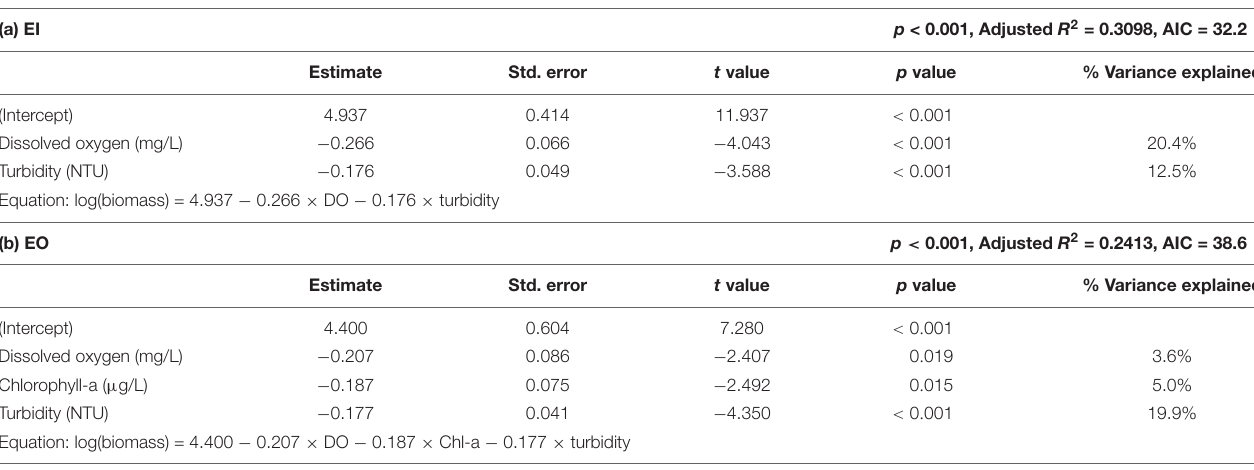
FIGURE 3 | Mean levels (+SEM) of turbidity (A) , dissolved oxygen [(DO; (B) ], pH (C) , and chlorophyll-a [Chl a; (D) ] obtained from the Environmental Protection Department of Hong Kong for water samples that were collected in inner Tolo Channel (EI) and outer Tolo (EO) during January 2004 to December 2004 (2004; before the trawl ban), June 2013 to May 2014 (2013–2014; after the trawl ban), and June 2015 to May 2016 (2015–2016; after the trawl ban). In each panel and site, bars with different letters are significantly different ( p < 0.05), whereas n.s. denotes no significant difference between the mean values among the 3 years. TABLE 2 | Results of stepwise multiple linear regression analysis of Platycephalus indicus biomass (dependent variable) with the environmental parameters (independent variables) in the inner (a; EI) and the outer Tolo Channel (b; EO) of Hong